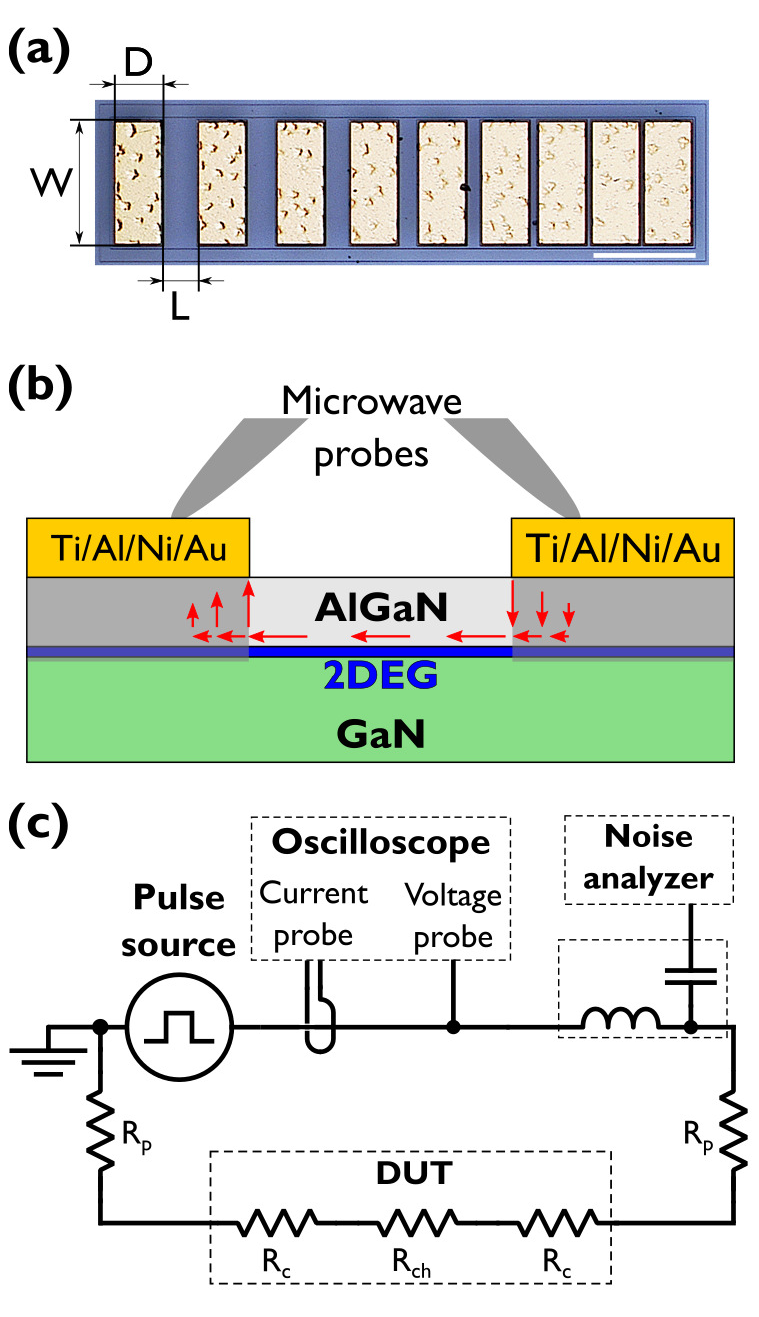
Figure 1. Microscope image of the TLM samples of the AlGaN/GaN channel with electrodes (of width W and length D ) ( a ) and intersection illustration of the AlGaN/GaN heterostructure with the 2DEG channel, showing the active part of the epitaxial structure and involving only two electrodes ( b ). Arrows illustrate the current flow. An illustration of the DUT connection in the electronic scheme is presented in ( c